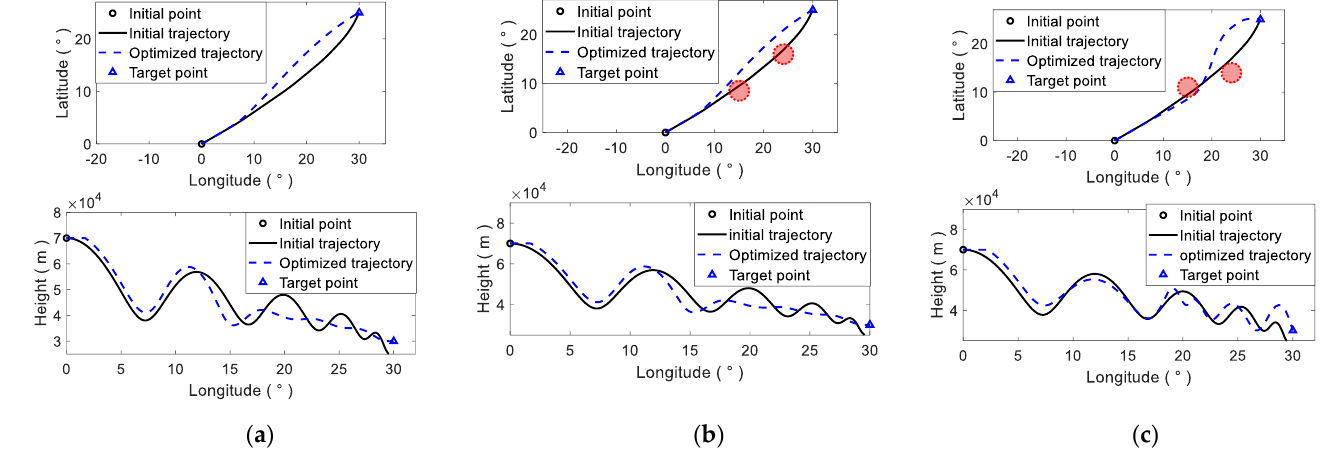
Figure 6. The generated optimized trajectories of cases: ( a ) is the longitudinal and lateral trajectories of case 1; ( b ) is the longitudinal and lateral trajectories of case 2; ( c ) is the longitudinal and lateral trajectories of case 3.